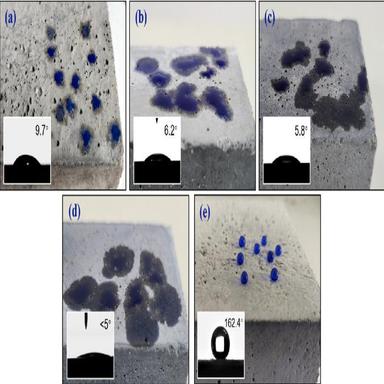
Comparison of the wettability of five types of concrete surfaces: (a) Ordinary concrete surface, CA ¼ 9.7, (b) Nano-silica coating concrete surface, CA ¼ 6.2, (c) Fly ash drifting beads coating concrete surface, CA ¼ 5.8, (d) Nano-silica þ Fly ash drifting beads coating concrete surface, CA < 5, (e) Concrete surfaces coated with superhydrophobic coatings, CA ¼ 162.4.